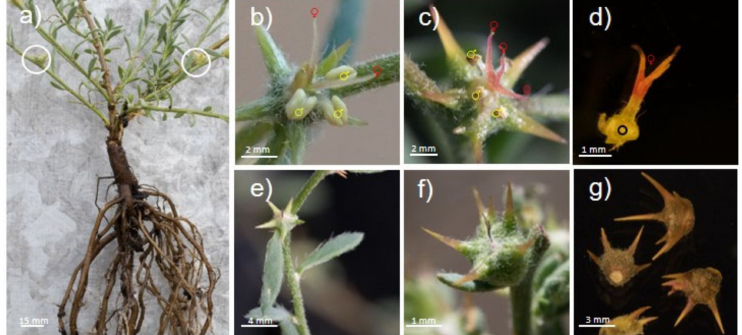
Figure 2. Habit, flowers, and fruit of Sclerolaena napiformis . ( a ) A thick rootstock develops within one year of germination and plants can re-shoot from base of stem following dieback. Developing fruit circled. The insignificant flowers, lack of petals, and exposure of stigmas and anthers to air currents are features typical of wind pollination. ( b ) Young flower with two stigmas ( anthers ( , two underdeveloped) visible. ( c ) An older flower with three stigmas ( ♂ anthers visible ( ). ( d ) Female reproductive organs excised from fruit showing stigma lobes ( ♂ single ovary (O). The timing of stigma receptivity is not known. ( e , f ) Developing fruit, with remnant of stigmas still visible ( f ). ( g ) Mature dry fruit collected from stems. Circular scar at base of one fruit shows the position of fruit attachment to the